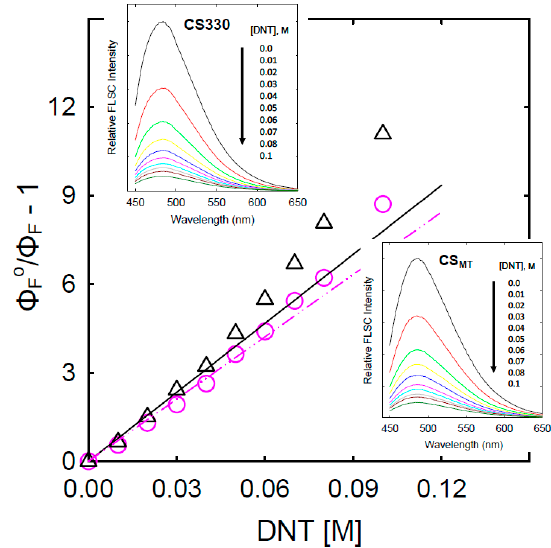
Figure 6. Stern–Volmer plots for the quenching of fluorescence emission intensity by DNT for CS330 (triangle, solid line) and CS MT (circle, dash ‐ dot ‐ dot line) in ethanol solutions, with the slopes (Stern–Volmer constants for the linear portion with low DNT concentrations) of 79 M ‐ 1 and 70 M ‐ 1, respec ‐ tively. Insets: The corresponding fluorescence emission spectra with the quenching at different DNT concentrations.